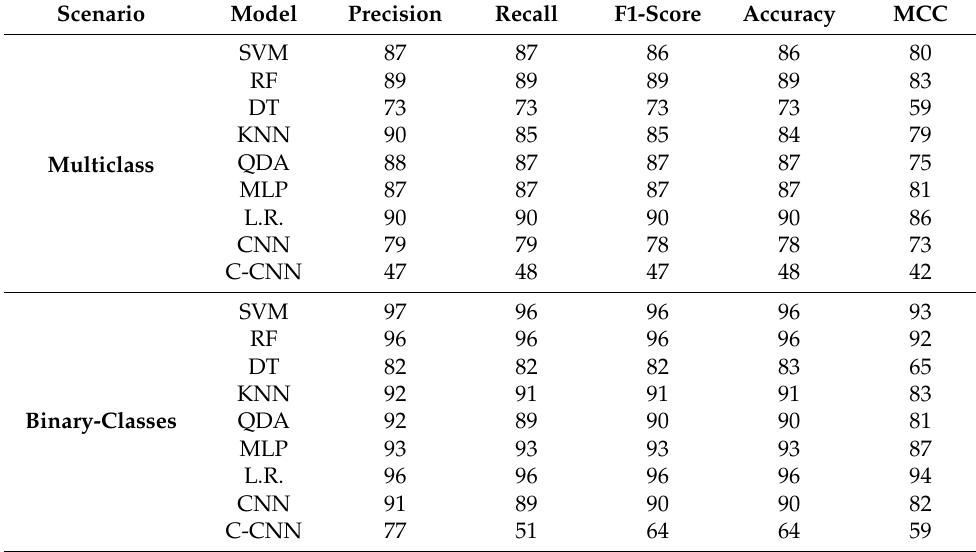
Table 7. Brief Comparison among The Proposed Machine Learning Models.